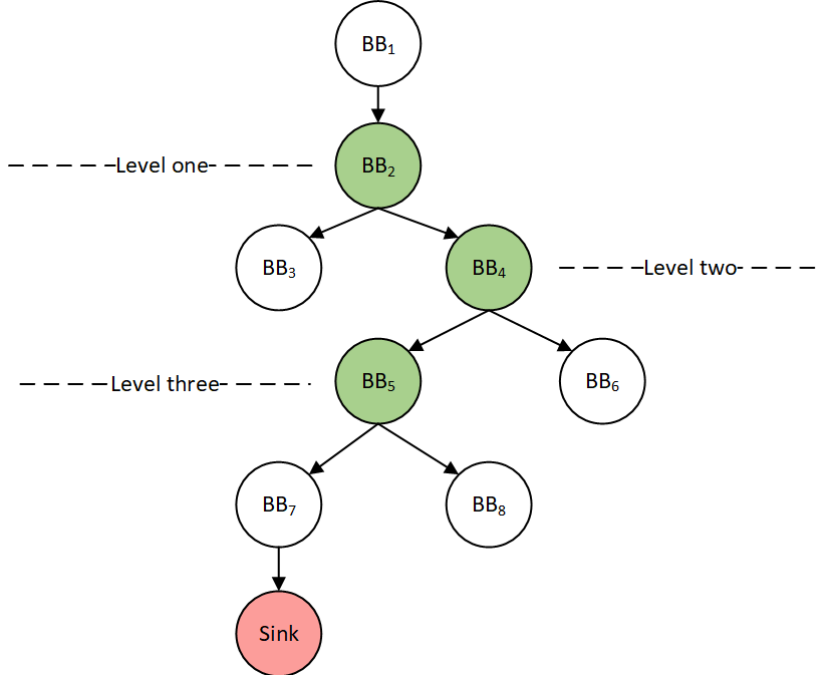
Figure 7 . CFG of sample code